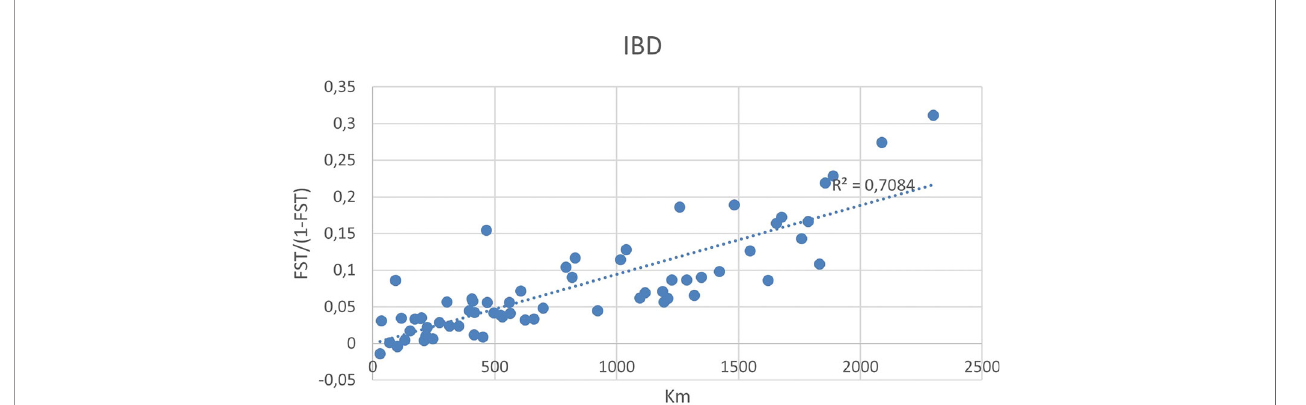
FIGURE 4 | Pairwise FST values of stations plotted against distance (km) between stations, costal stations only.